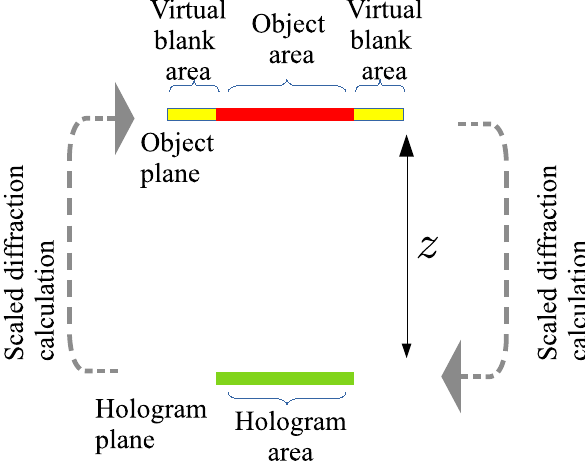
Figure 2. Scaled diffraction-based